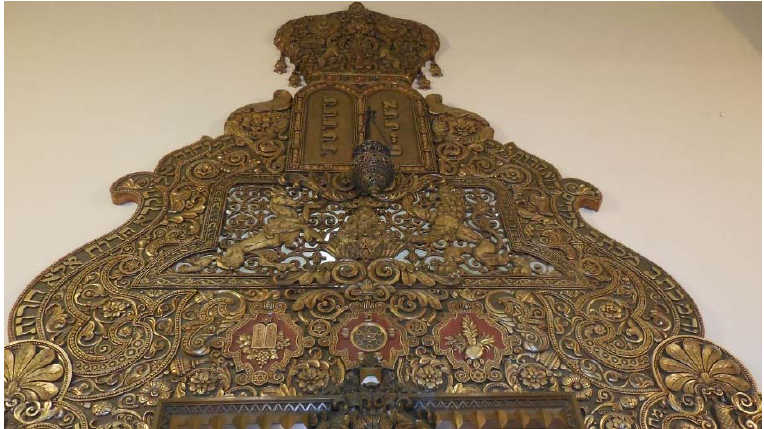
Figure 11. The upper part of the ark.